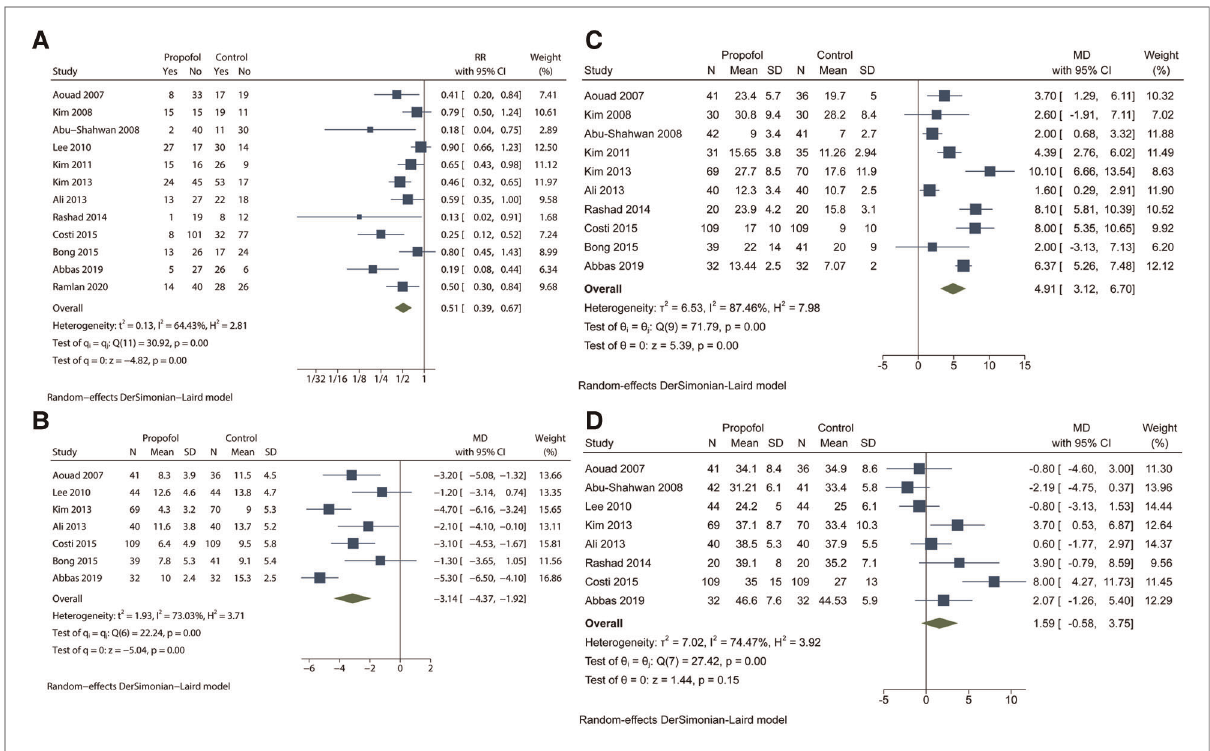
FIGURE 2 Analyses based on the pooled effect size. ( A ) the meta-analysis for the EA incidence. ( B ) the meta-analysis for the PAED scores. ( C ) the meta-analysis for the awakening time. ( D ) the meta-analysis for the PACU